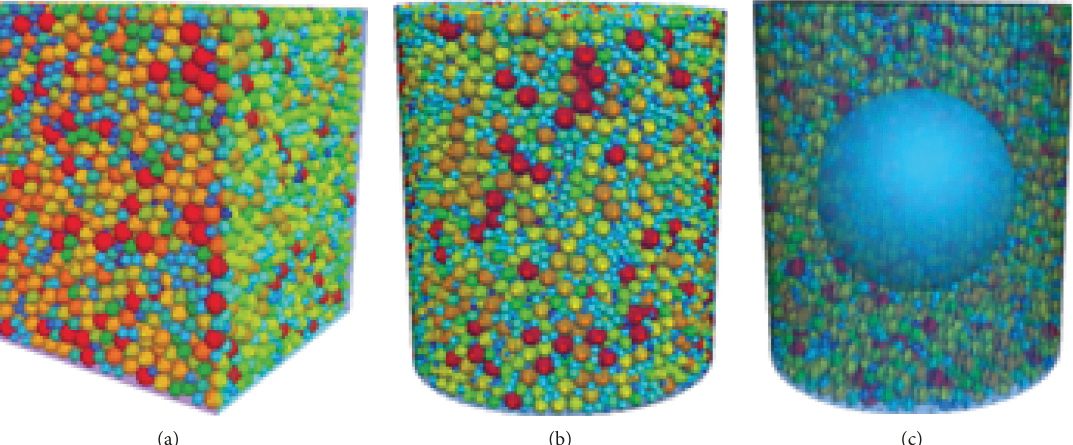
Figure 1: Digital simulation specimen.